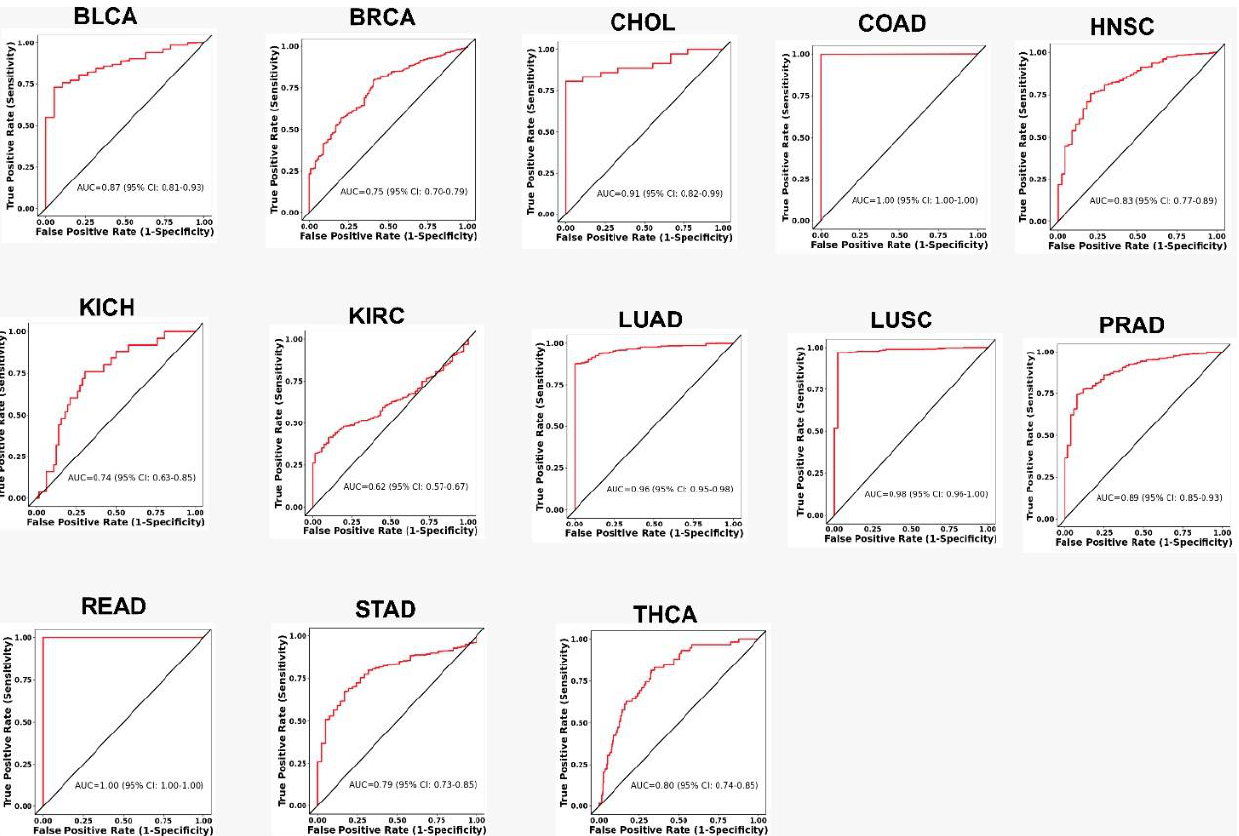
Figure 5. ROC curves for 13 TCGA cohorts’ data. Expression data from TCGA cohorts for tumor and normal samples were used to perform the